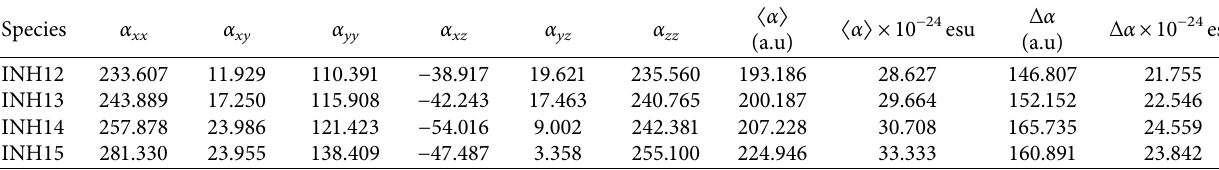
Table 7: Static frst hyperpolarizability of the studied compounds, calculated at ω � 0, at the B3LYP-D/6-311G (d,p) level of theory in the gaseous phase.